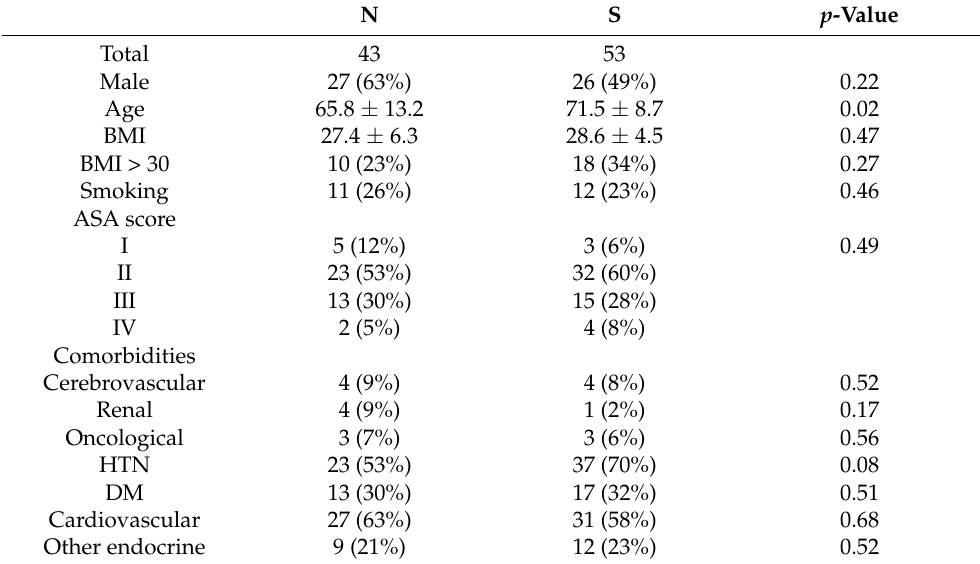
Table 1. Demographic variables, basic health status, and comorbidities in both